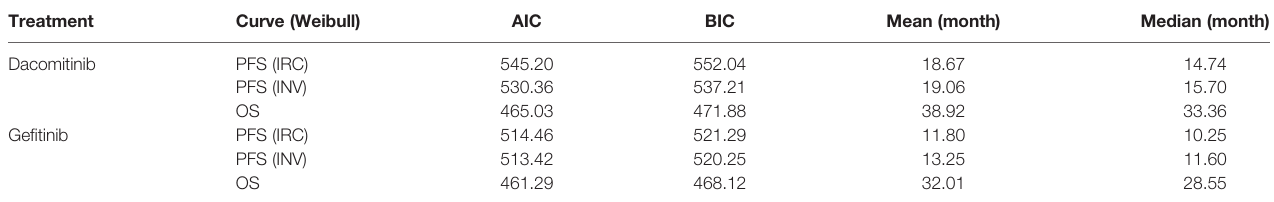
TABLE 2 | Goodness-of-Fit Statistics for the PFS and OS by treatment groups.